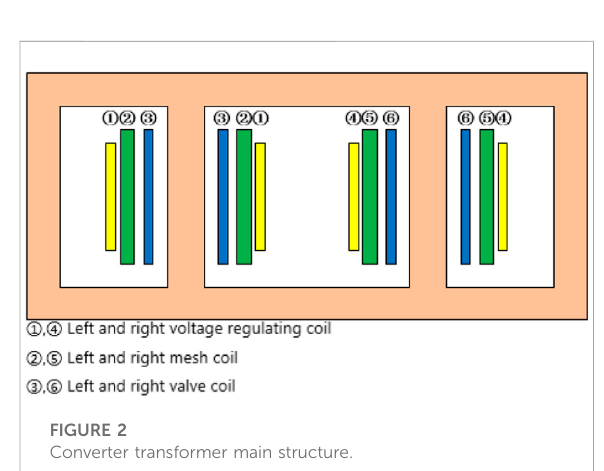
FIGURE 2 Converter transformer main